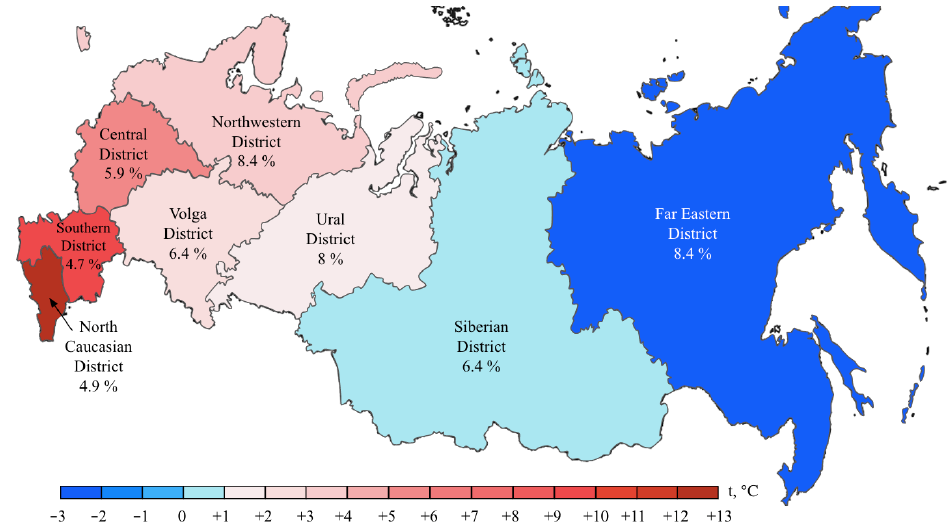
Figure 4. BRAF mutation frequencies in CRC patients from various region of Russia. The color bar represents an average annual temperature.